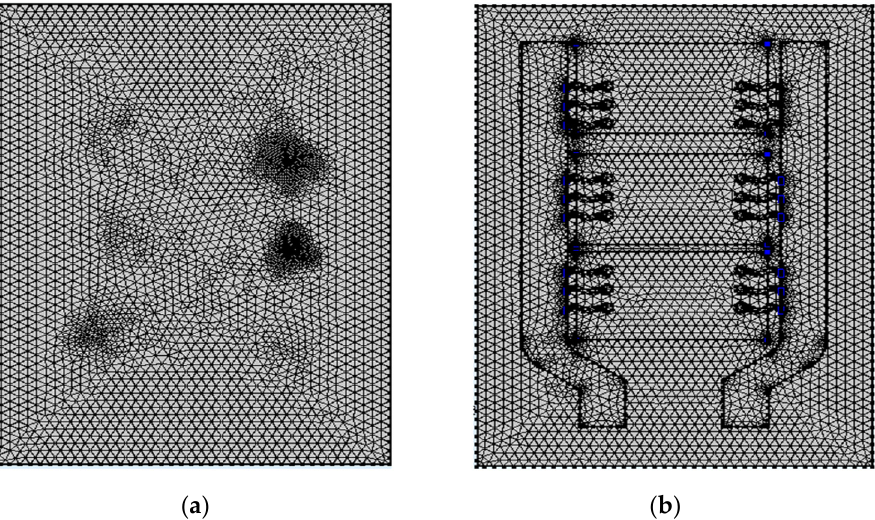
Figure 5. Mesh built in COMSOL Multiphysics for the model geometry of the tablecloth: ( a ) face of fabric substrate (back side) and ( b ) coating face (front side).